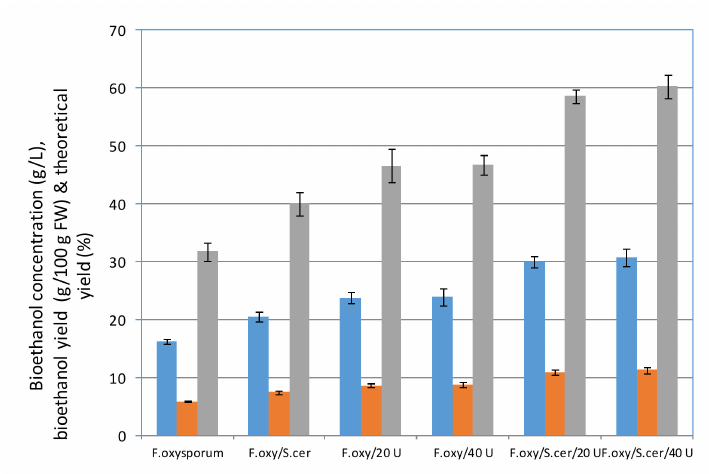
Figure 4. Maximum values of bioethanol production (g / L) ( (cid:4) ), bioethanol yield (g / 100 g FW) ( (cid:4) ), theoretical yield (%) ( (cid:4) ).